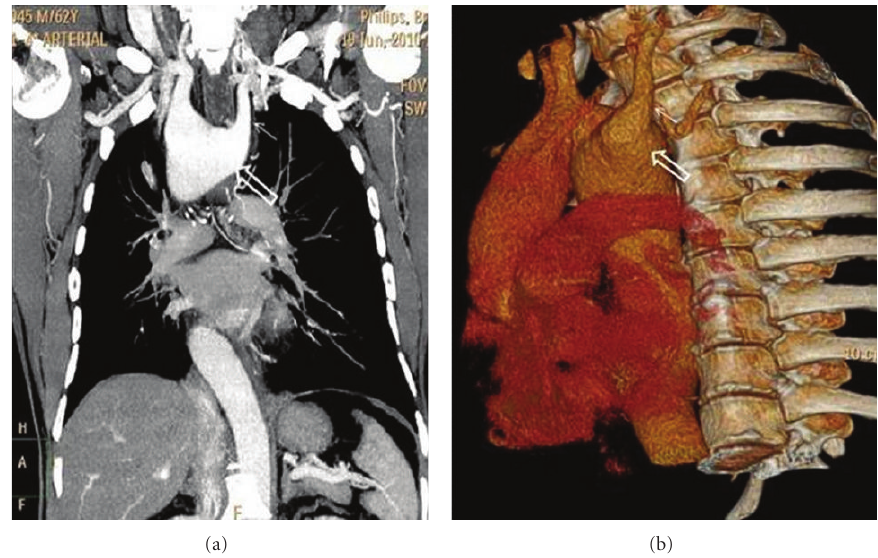
Figure 2: Coronal reconstruction (a) and volume-rendered (b) images of thorax demonstrate right-sided aortic arch with aberrant left subclavian artery (arrow) showing Kommerell’s diverticulum (open arrow) at its